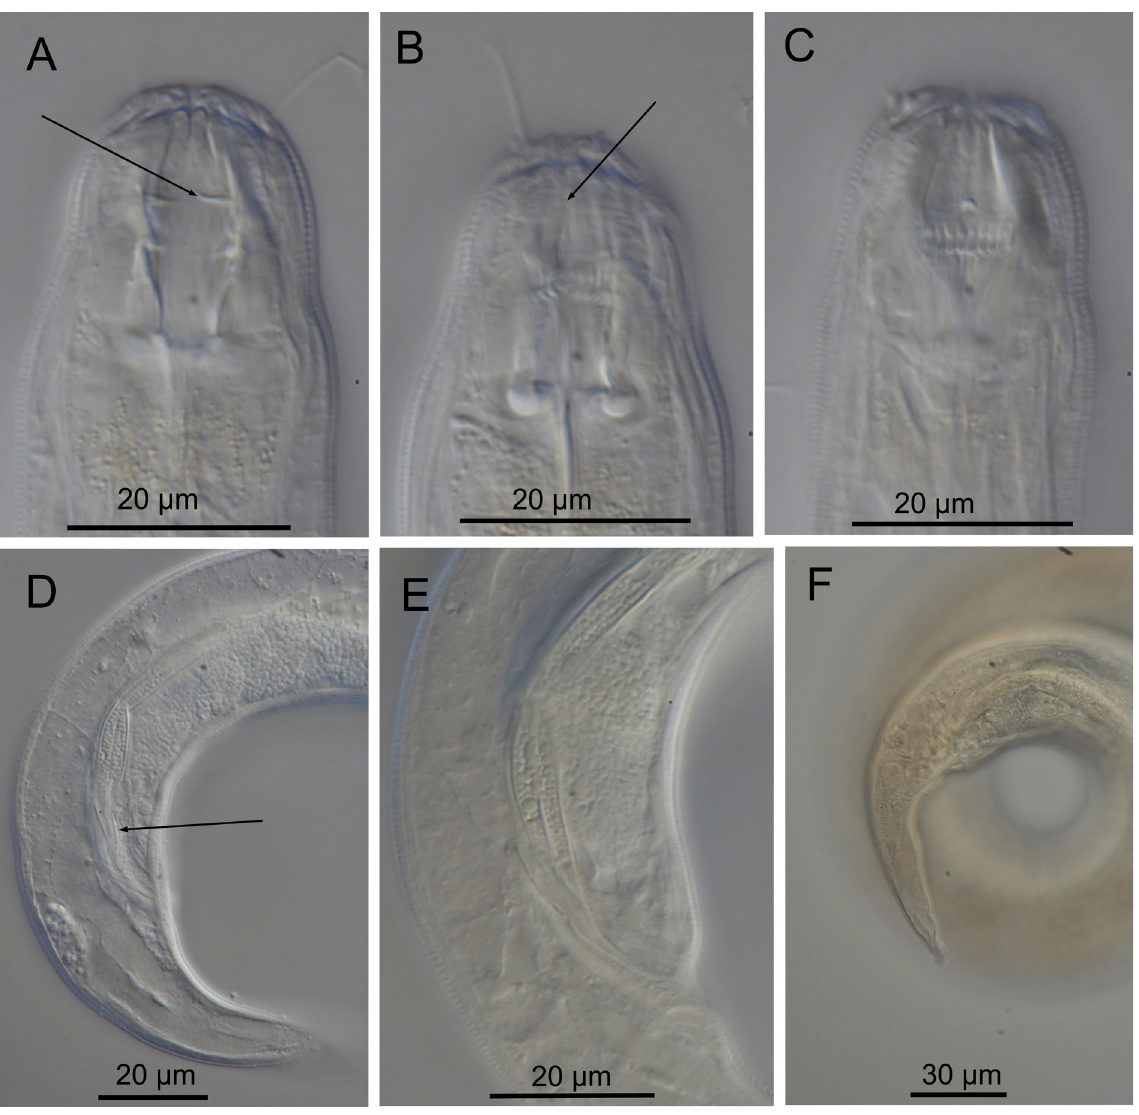
Fig. 9. Cobbionema acuminata sp. nov. Light micrographs. A . Stoma of male holotype (SMNH Type- 9221) showing stoma armament, arrow pointing to the right ventrosublateral tine. B . Anterior part of a male showing sphincter muscle surrounding the anterior stoma chamber (arrow). C . Stoma of male holotype (SMNH Type-9221) showing the arrangement of the pointed projections and the left ventrosublateral tine. D–E . Caudal region of male paratype (SMNH Type-9222) showing the crura (arrow) and spicule. F . Male tail, holotype (SMNH